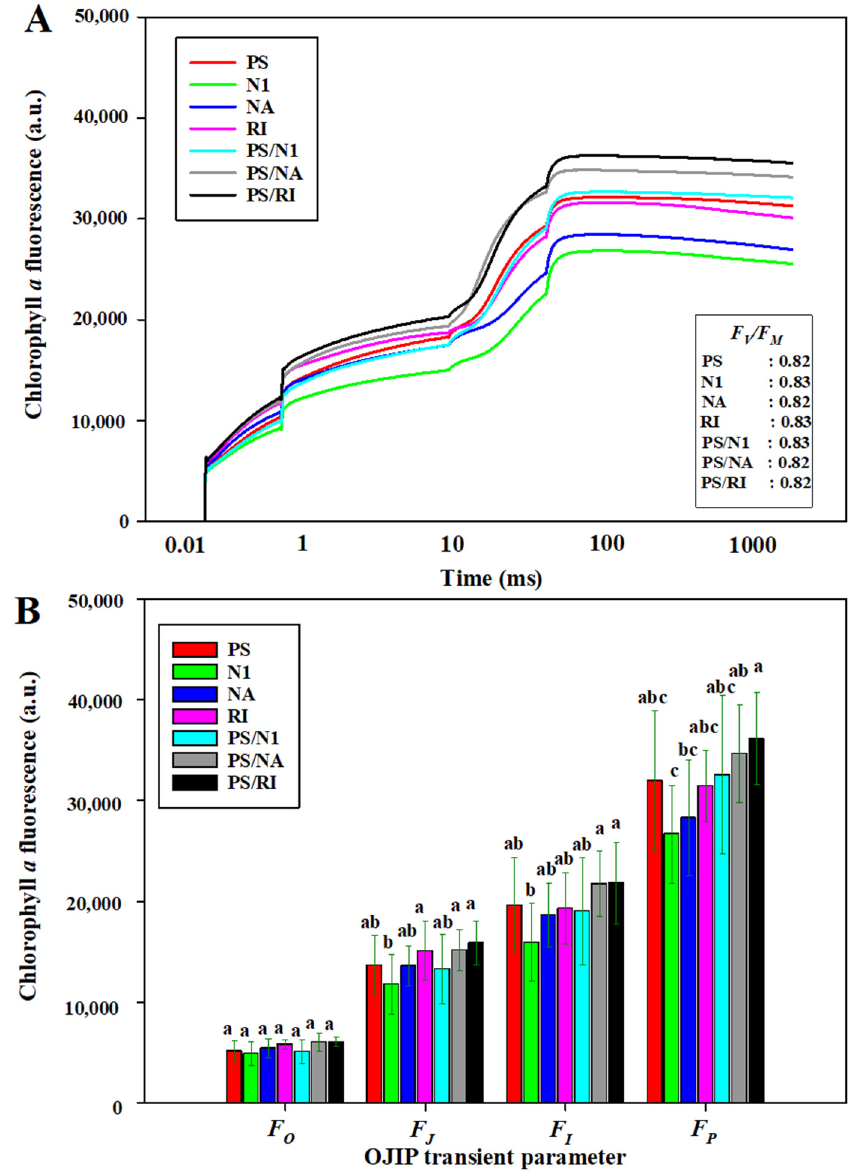
Figure 3. OJIP transient parameter plotted on a logarithmic time scale ( A ), and the parameter values ( B ) of one scion, three rootstocks, and three grafted cut rose flowers grown in the greenhouse during the summer season. PS: scion plant of spray rose Rosa hybrida cv. Pink Shine; N1: rootstock of Rosa multiflora cv. Hort No. 1; NA: rootstock of Rosa canina cv. Natal Briar; RI: rootstock of Rosa indica cv. Major; PS/N1: PS grafted onto N1; PS/NA: PS grafted onto NA; PS/RI: PS grafted onto RI. Vertical bars are standard deviations ( n = 15). Small letters at the data points indicate mean separation between the values by Duncan’s multiple range test at p =